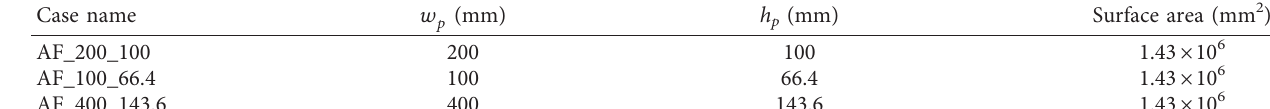
Table 4: Annular finned cooling pipe with the same surface